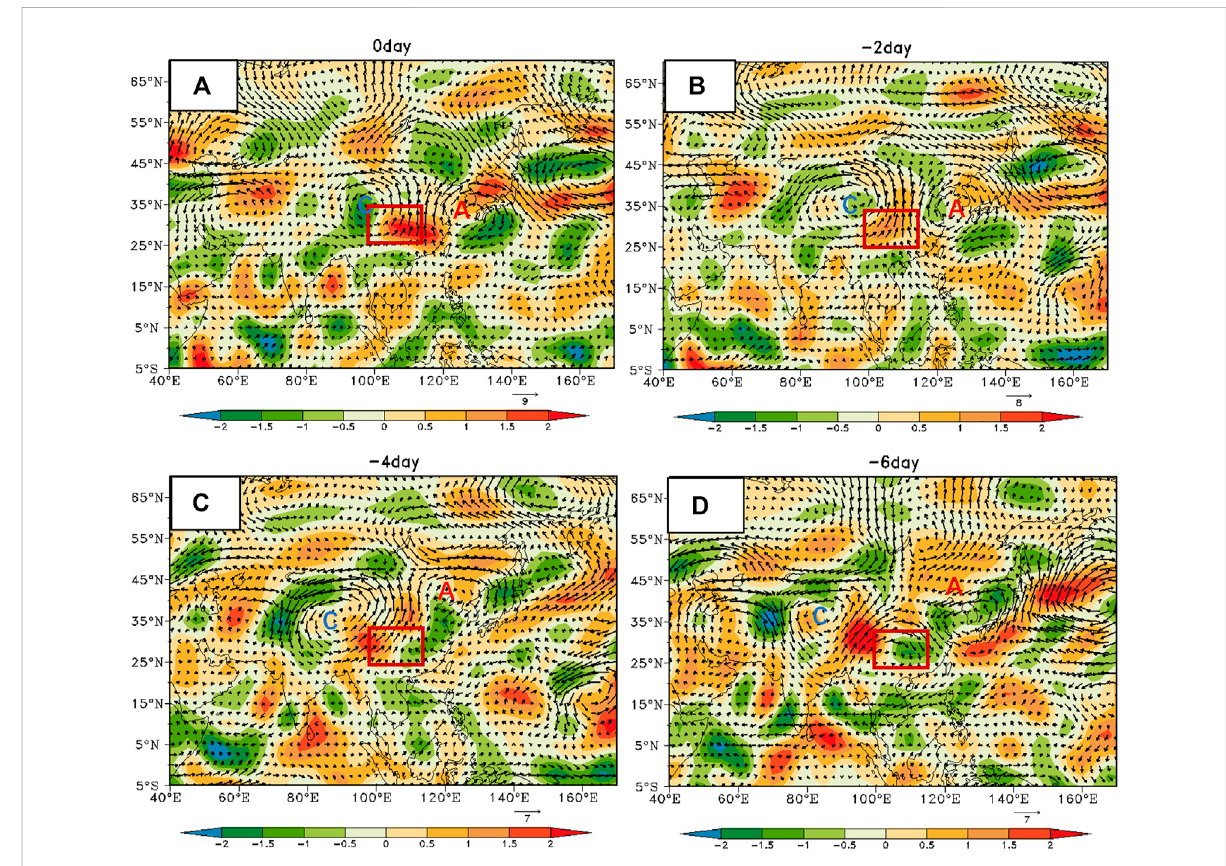
FIGURE 15 Evolutionofthelow-frequency(15 – 30 days)divergence(shading,unit:10 − 6 S − 1 )andwind(vector, unit:m/s) fi eldat200 hPafrom6 daysbefore the precipitation to 0 day after onset in the Guizhou